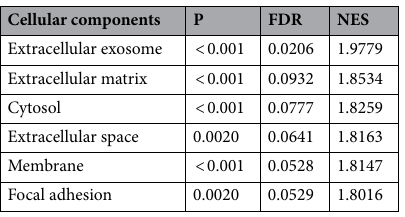
Table 4. The GSEA of CD63 for cellular components.